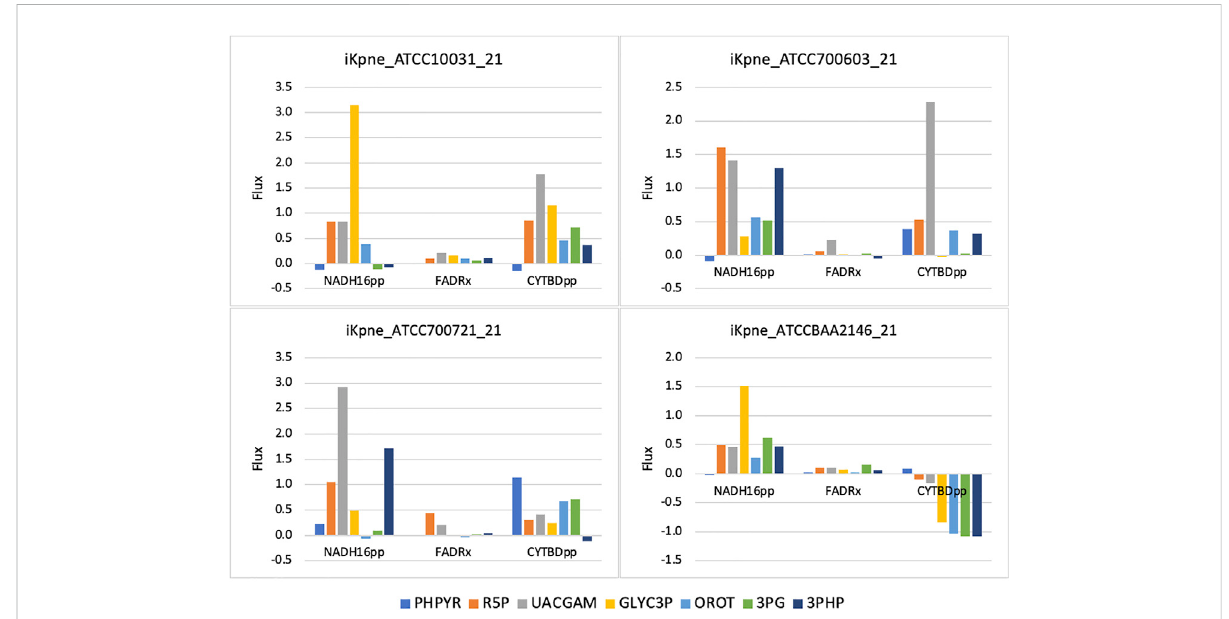
FIGURE 2 Oxidative phosphorylation fl uxes changes upon metabolite addition. The reaction abbreviations are as follows: NADH16pp, NADH dehydrogenase (ubiquinone-8 and 3 protons) (periplasm); FADRx, FAD reductase; CYTBDpp, cytochrome oxidase bd (ubiquinol-8: 2 protons)